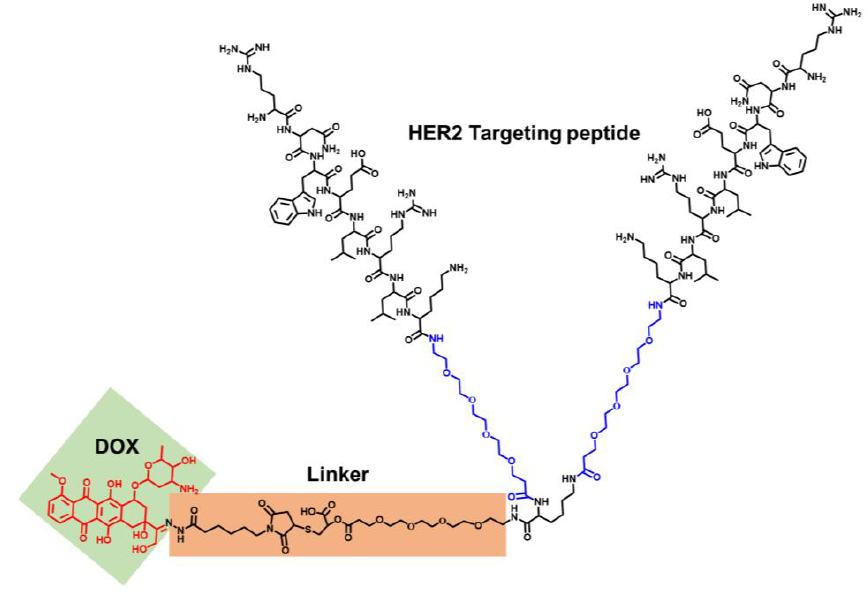
Figure 1. The structures of the HER2-targeting peptide – DOX conjugate (PDC).